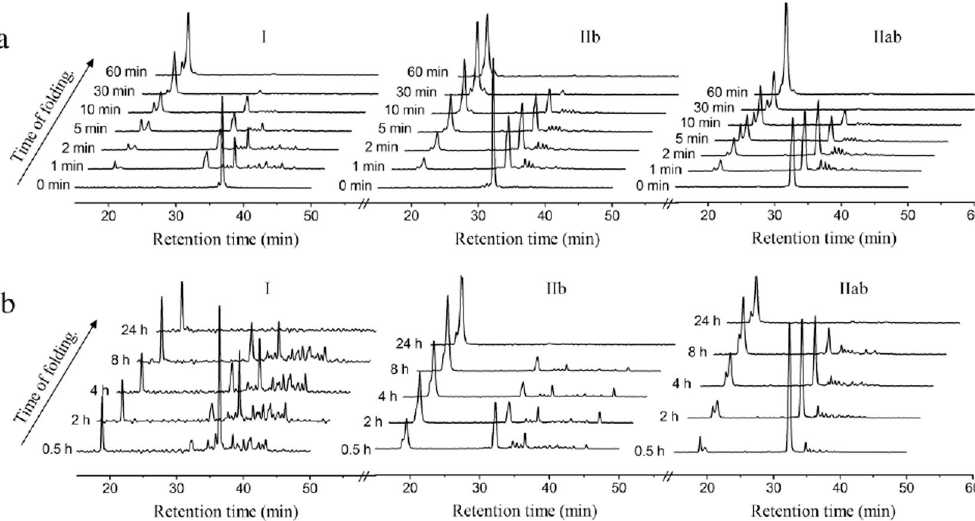
Figure 7. Stop/go folding of the major folding/unfolding intermediates of NvCI. Acid-trapped intermediates (I, IIb and IIab) were purified by RP-HPLC, freeze-dried, and dissolved in Tris-HCl (pH 8.4) to reinitiate the folding reaction either in the absence ( b ) or presence ( a ) of 1 mM GSSG. Folding intermediates were subsequently trapped with acid at different time points and analyzed by RP-HPLC. The chromatograms at 0 minutes (shown in a) were obtained after resuspending the lyophilized intermediates in TFA 1% as a control of purity and homogeneity of each species.